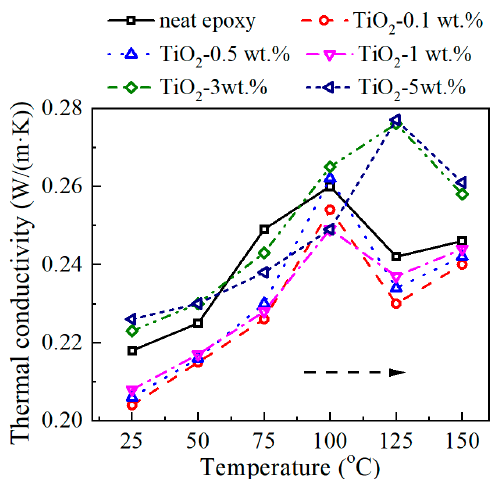
/ TiO ff erent 2 samples at di